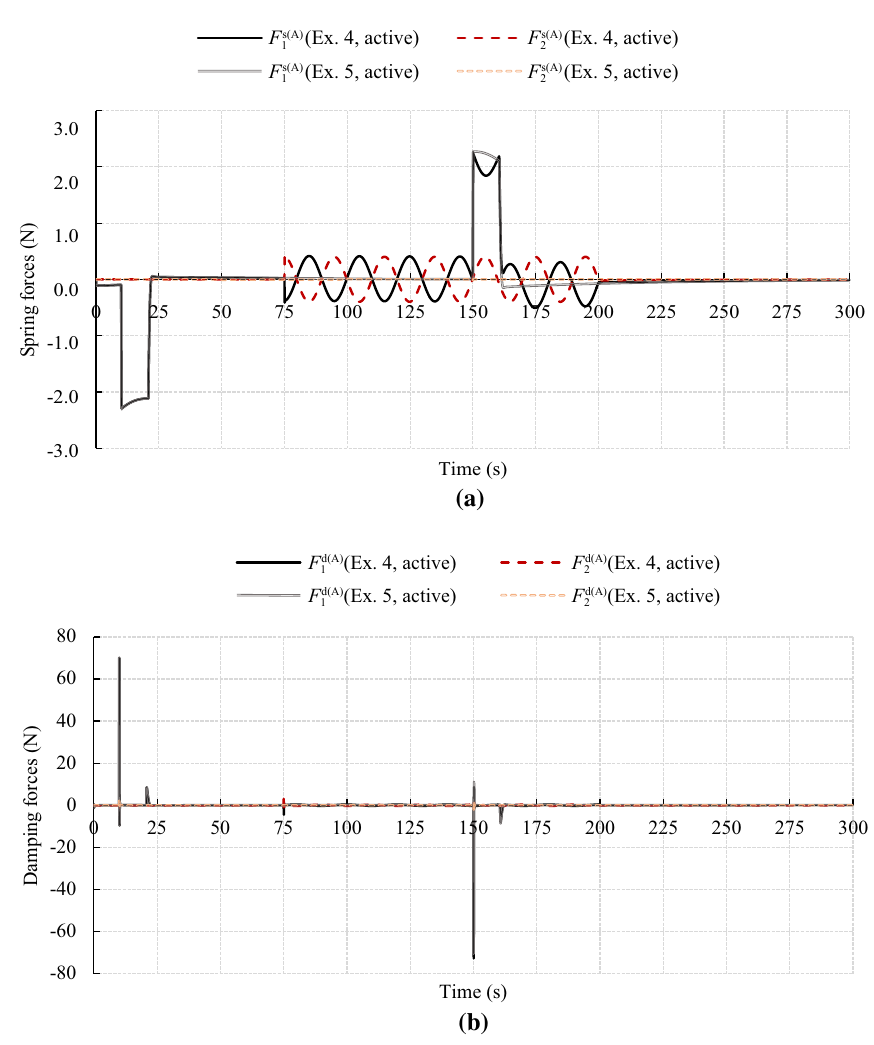
Fig. 11 Response action of the active vibration damping systems: a coupler spring forces F s A ð Þ F d A ð Þ and F d A ð Þ vs. 1 2